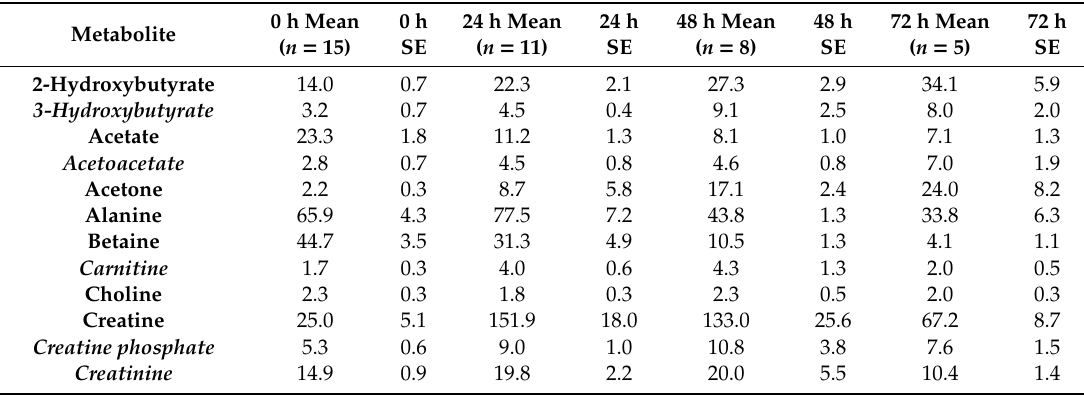
Table 2. Mean concentrations ( µ M) and standard errors of the means ( µ M) for individual metabolites at each time Table 2 . Mean concentrations ( μ M) and standard errors of the means ( μ M) for individual metabolites at each time point.